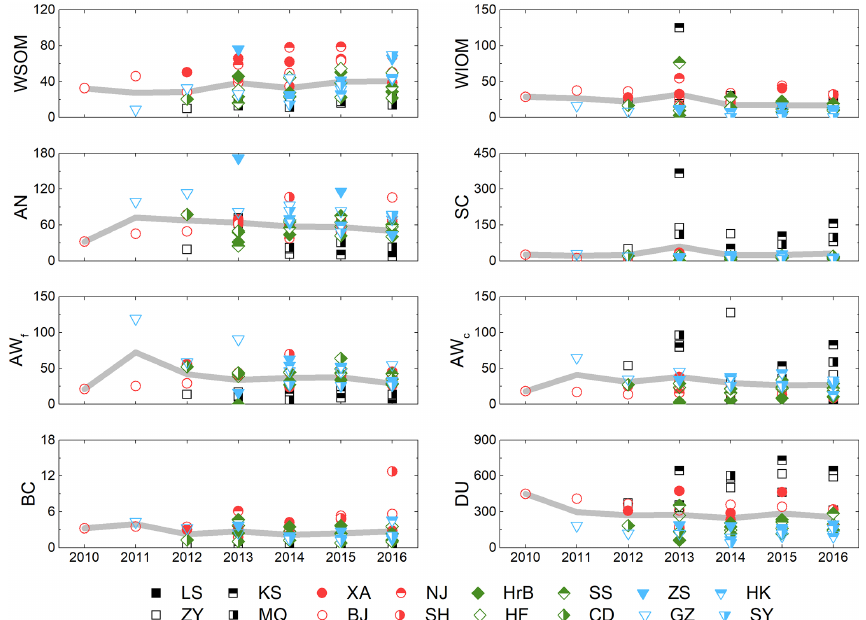
Figure 11. The interannual variations in mean aerosol component mass concentrations integrated over the whole atmospheric column with SONET sites from 2010 to 2016. The gray line represents the mean mass concentration of aerosol components averaged over the 16 sites; the points in each graph show the yearly value at each site. The abbreviations for the site names are from Table